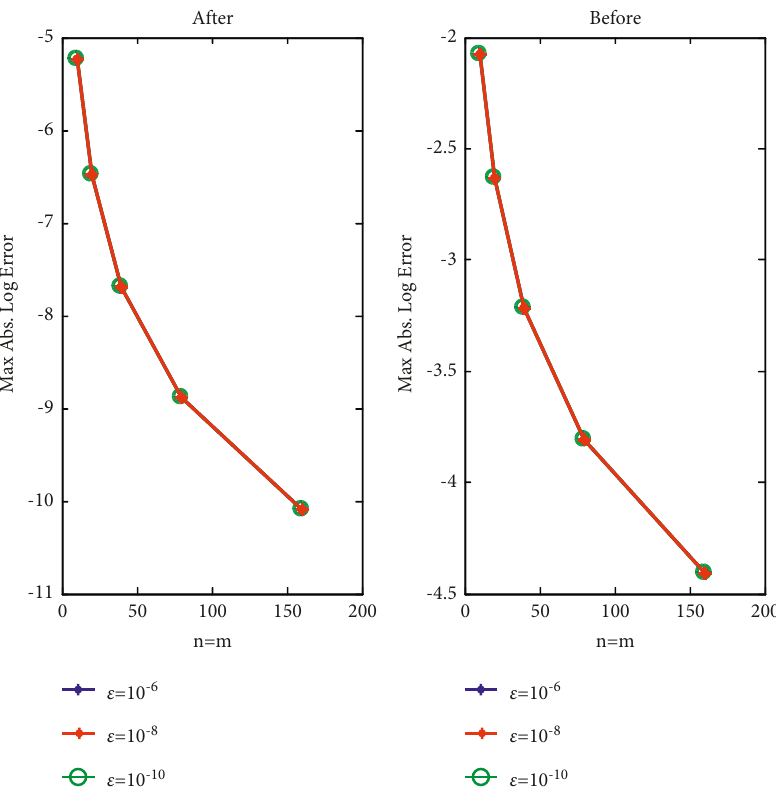
Figure 1: Log-log plot of maximum absolute errors before and after the Richardson extrapolation method applied for Example 1.